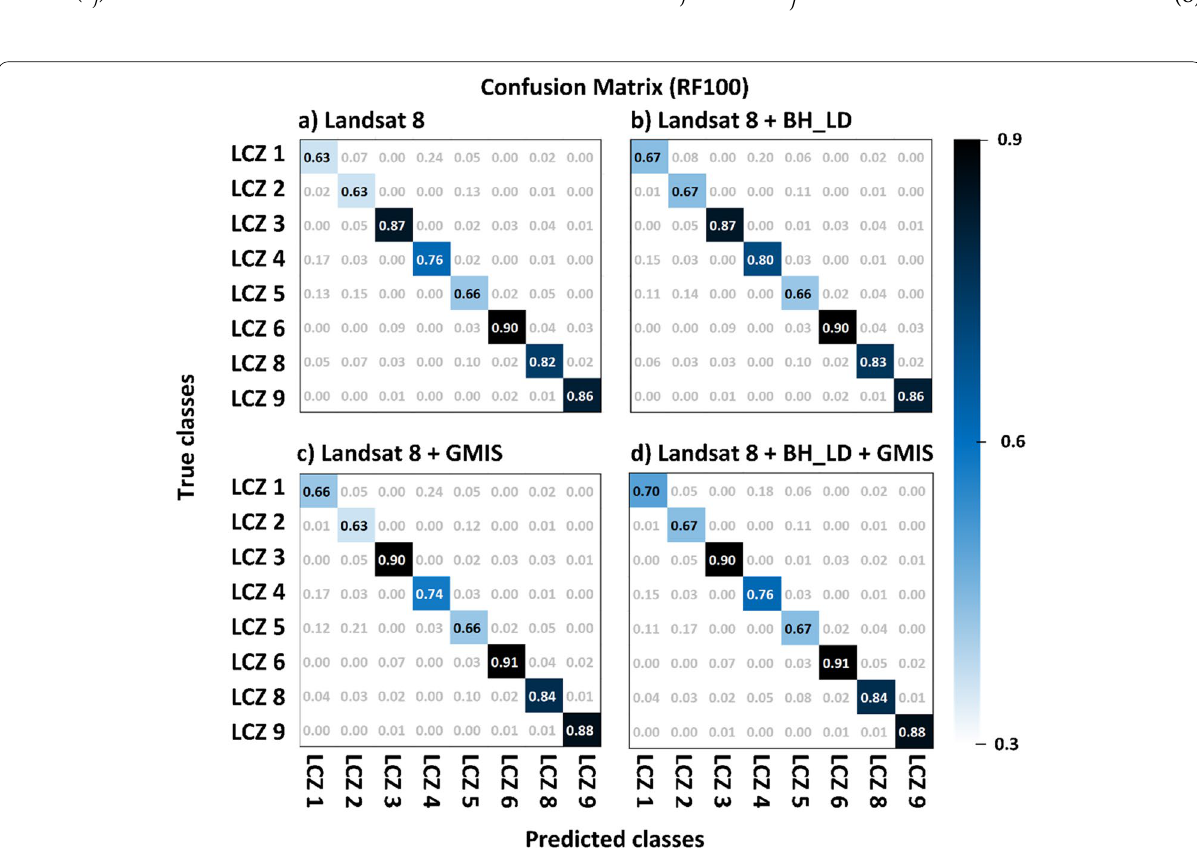
Fig. 7 The confusion matrix of the urban‑type classes from RF100 classifier using a LS8, b LS8 input